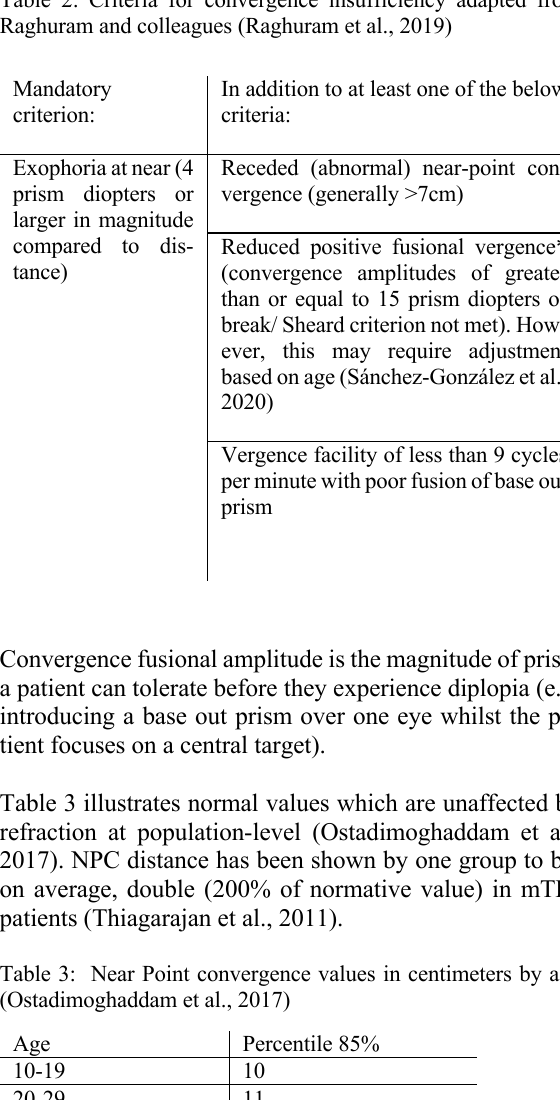
Table 2: Criteria for convergence insufficiency adapted from